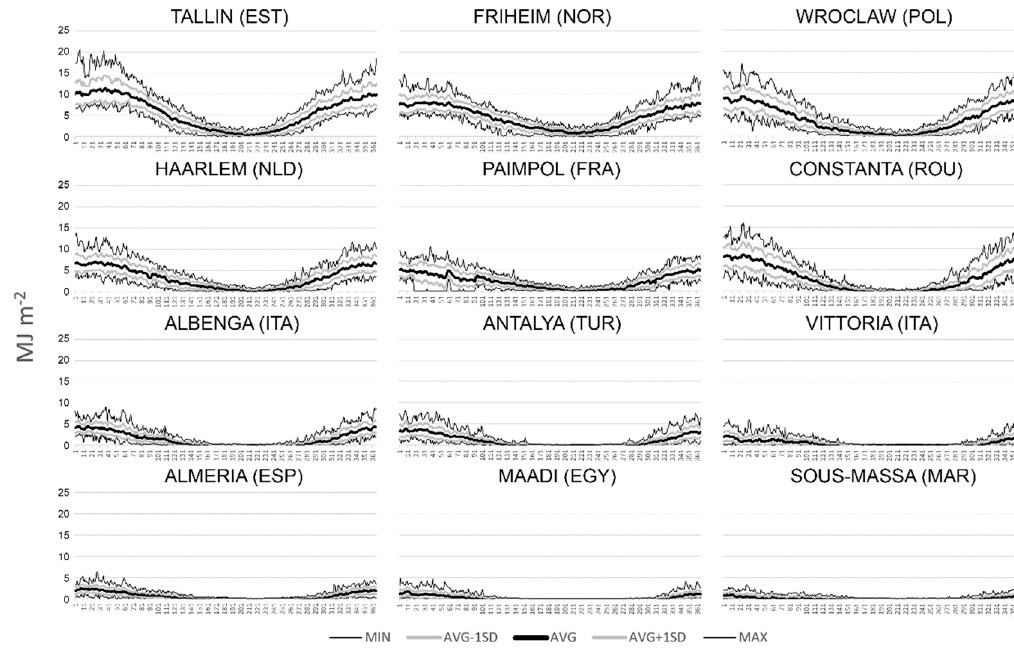
Figure 1. The energy requirements for growing rose plants for cut rose flowers in protected cultivation with the temperature set at the optimal range for this floriculture crop in different Euro-Mediterranean countries. Values reported are minimum, maximum, average ± 1 SD.